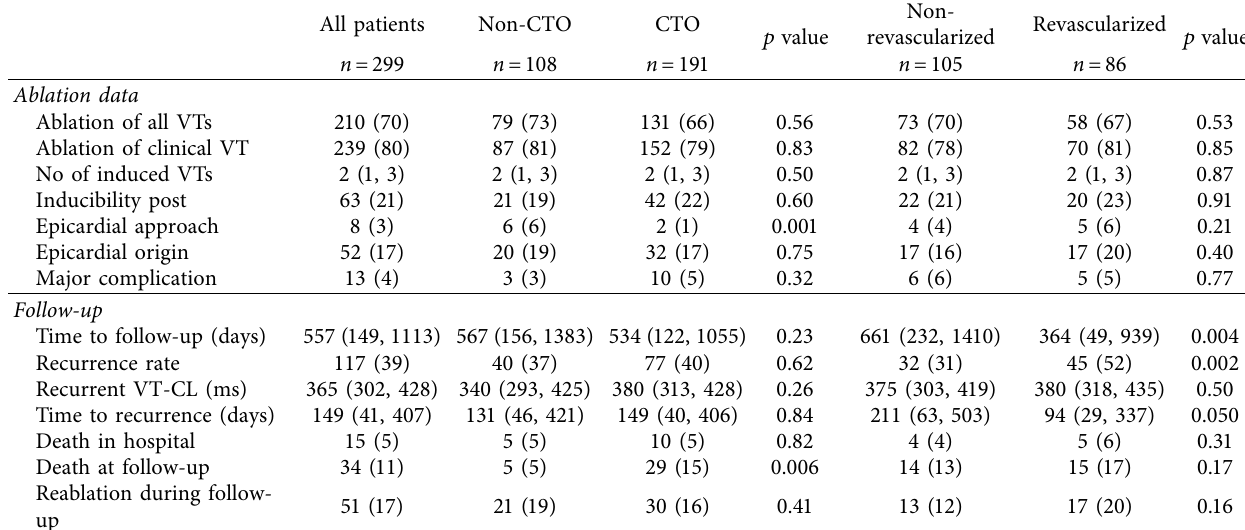
Table 2: Outcome parameters for CTO and non-CTO patients as well as nonrevascularized and revascularized patients.